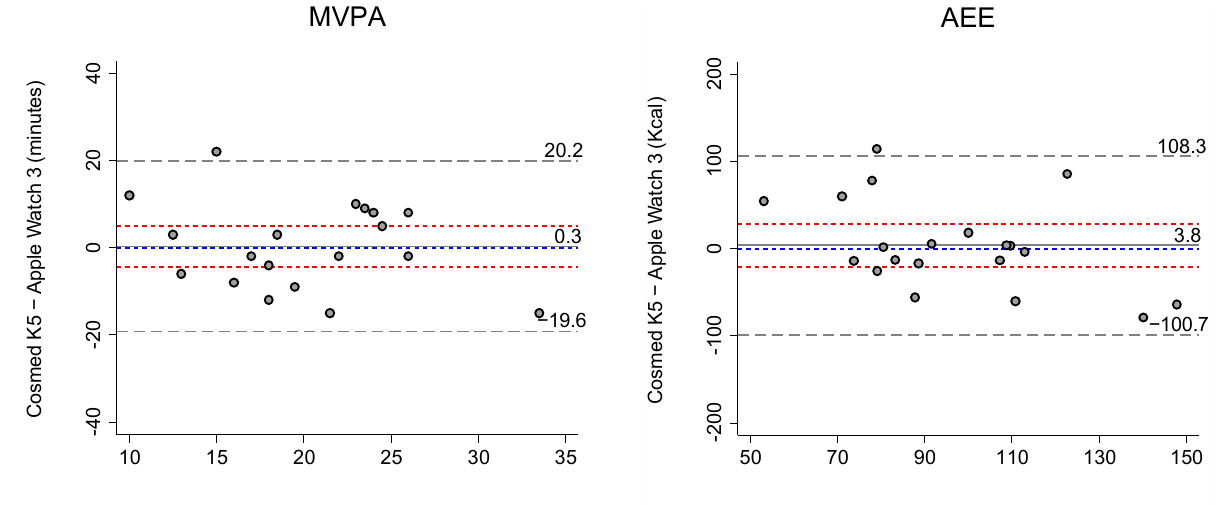
Figure 1. Bland-Altman Plots for comparing Moderate-to-Vigorous Physical Activity (MVPA) and Active Energy Expendi- ture (AEE) estimates between the K5 and Apple Watch 3. Blue short-dashed lines show the line of equality. Solid lines and red short-dashed lines indicate mean bias and 95% confidence interval of the mean bias, respectively. Dashed lines show 95% limits of agreement (±1.96 standard deviation).